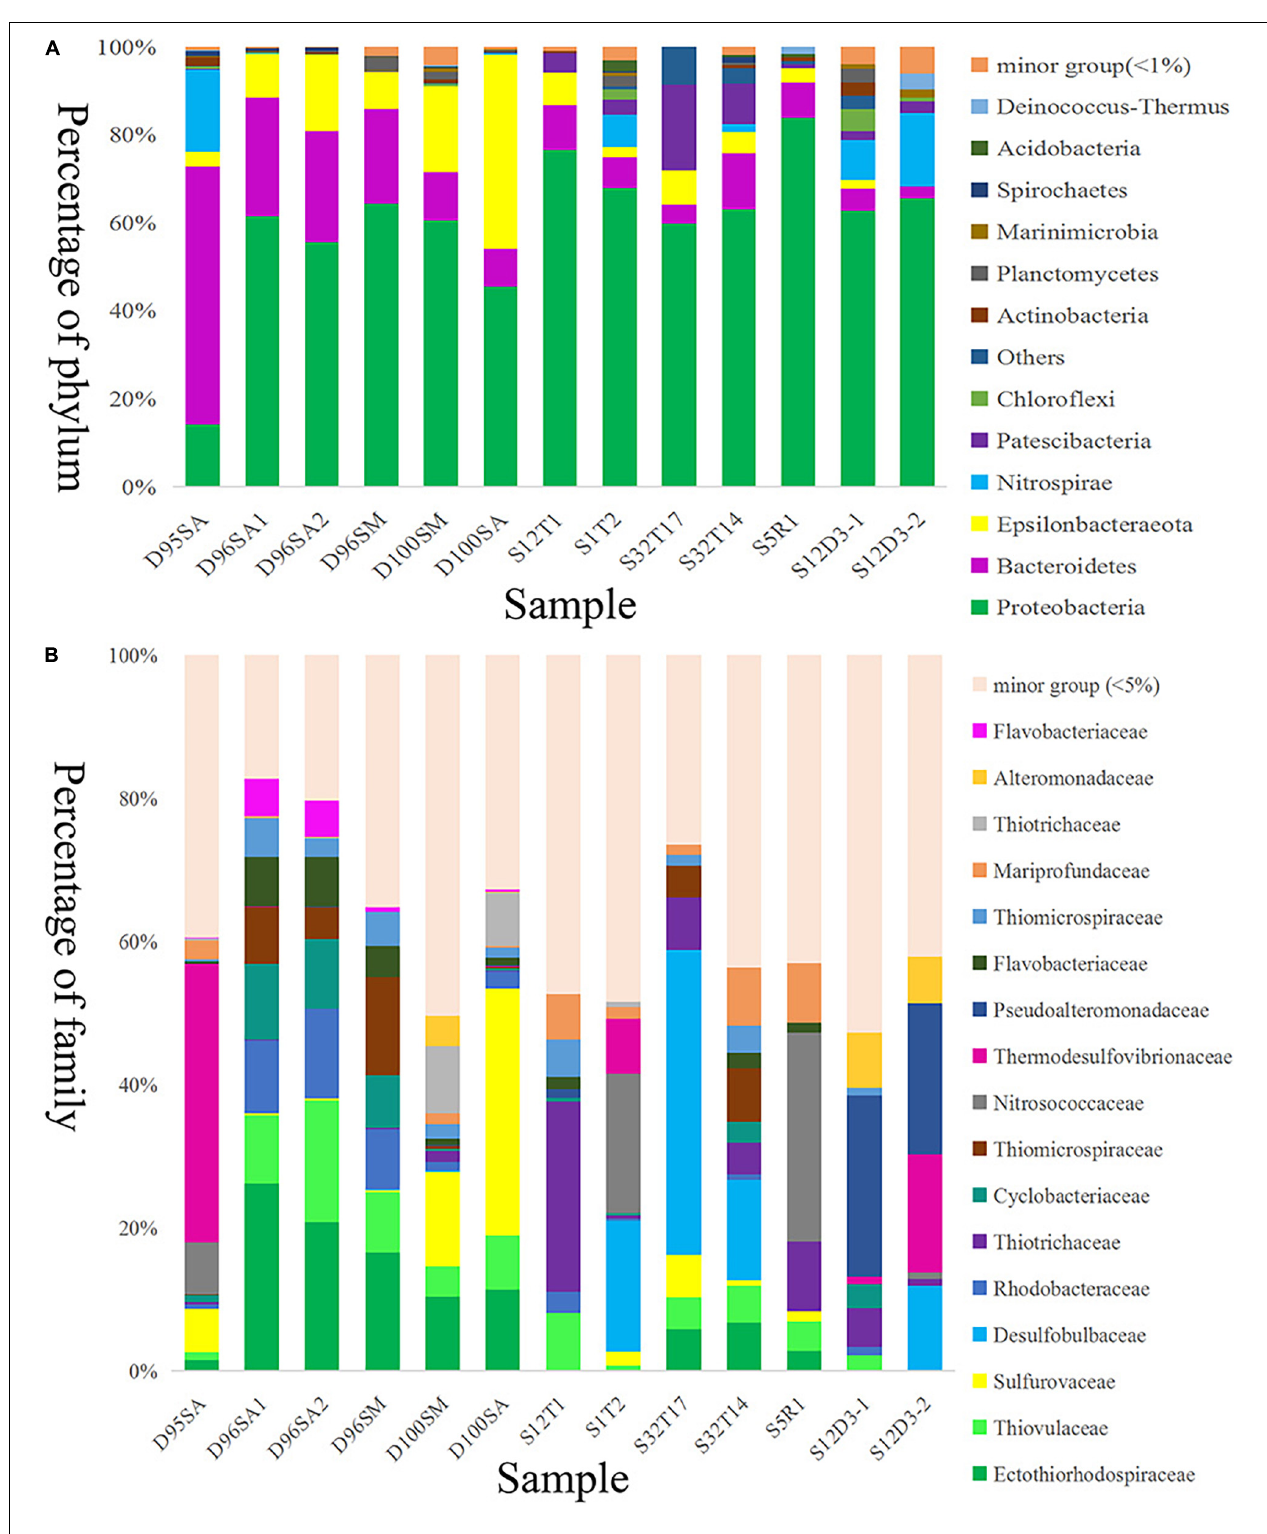
FIGURE 2 | Microbial community structures of hydrothermal samples. Taxonomic classification of operational taxonomic units (OTUs) at 97% similarity was performed by comparing with reference sequences of SILVA database v138. The microbial community structures were shown at phylum (A) and family (B) levels. D100SA, D96SA1, D96SA2, and D95SA refer to 16S rRNA gene amplicons; D100SM and D96SM are 16S miTags. The other samples are referred to Supplementary Table 2 .